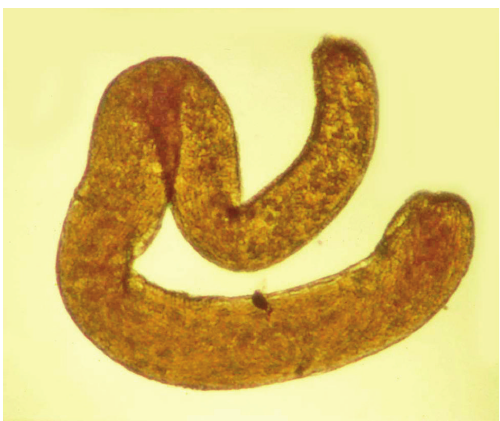
Figure 15: Female of the allantonematid Formicitylenchus orego- nensis removed from the body cavity of Camponotus vicinus in Oregon, USA